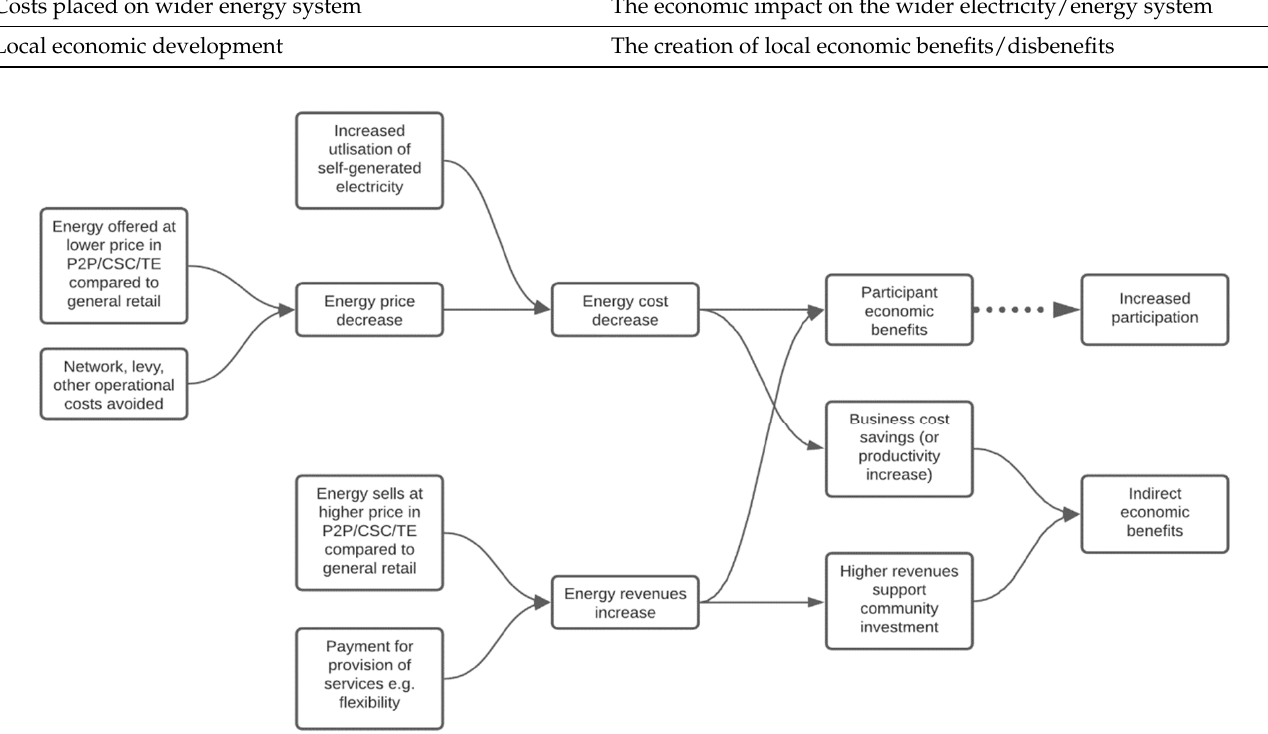
Table 4. Summary of economic value dynamics of P2P, CSC and TE models.